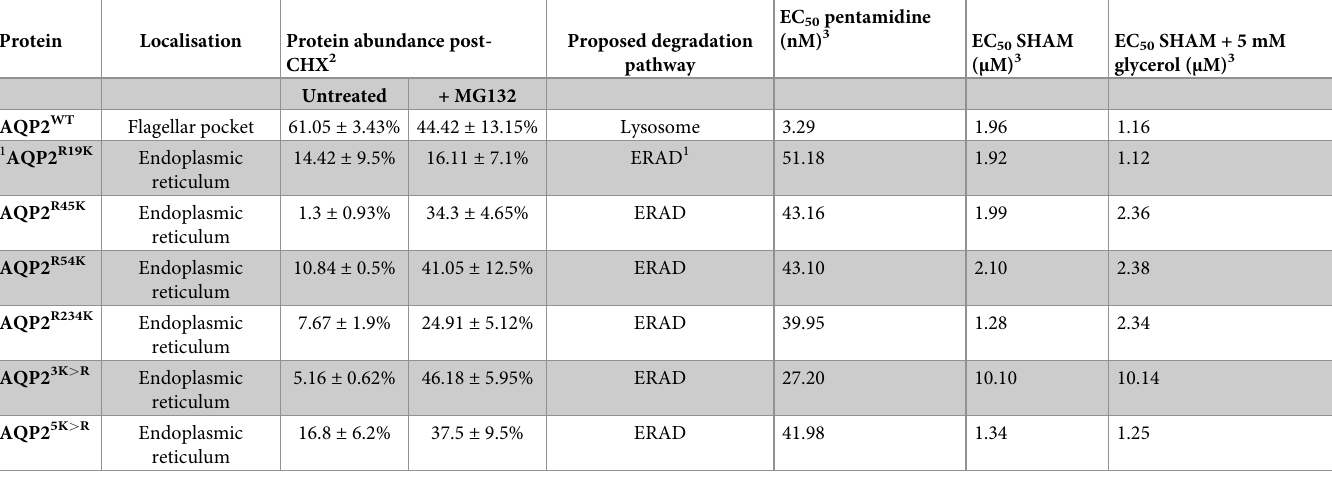
Table 1. Summary of the impact of cytoplasmic lysine mutagenesis on TbAQP2 localisation and function. Protein